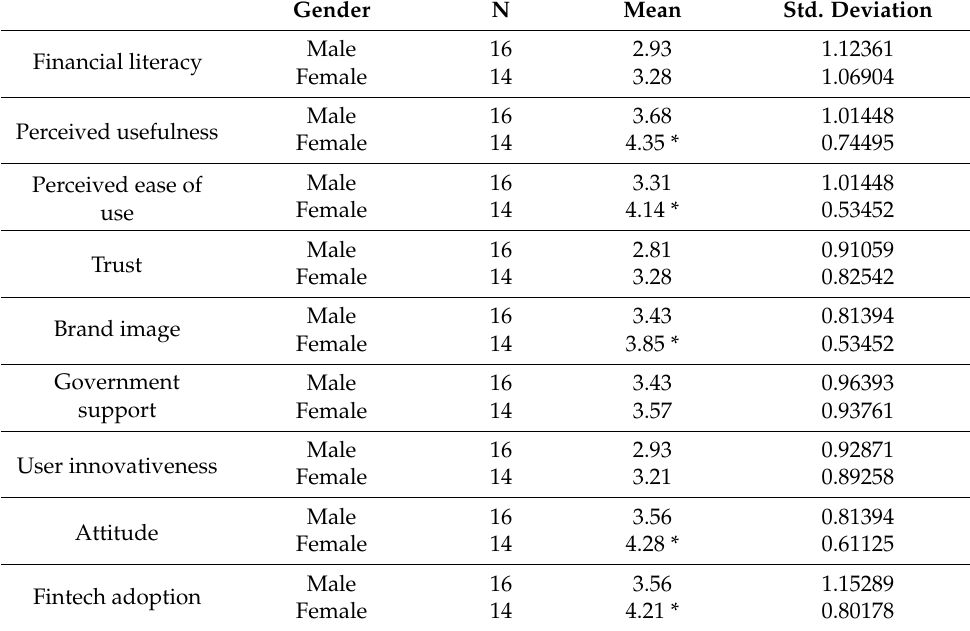
Table 16. Comparing Gender means for all Research Variables.